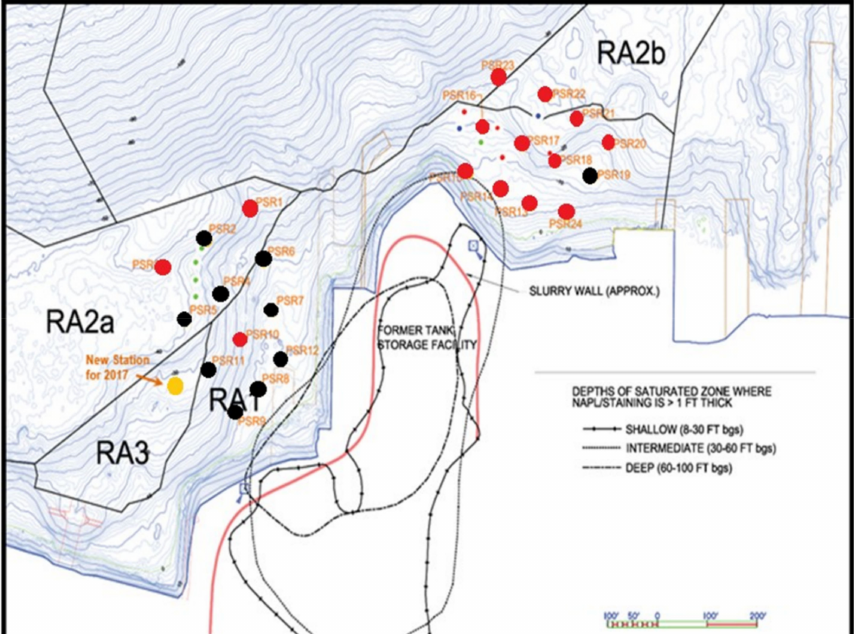
Figure 2. SPME sampling locations for the 2010 and 2018 sampling event at Puget Sound Resources Superfund Site. SPME sampling locations that had an increase in porewater concentration in 2018 compared to 2010 are marked red; those that did not increase are black. Penetrations refer to depth probing of the cap several years after its placement.